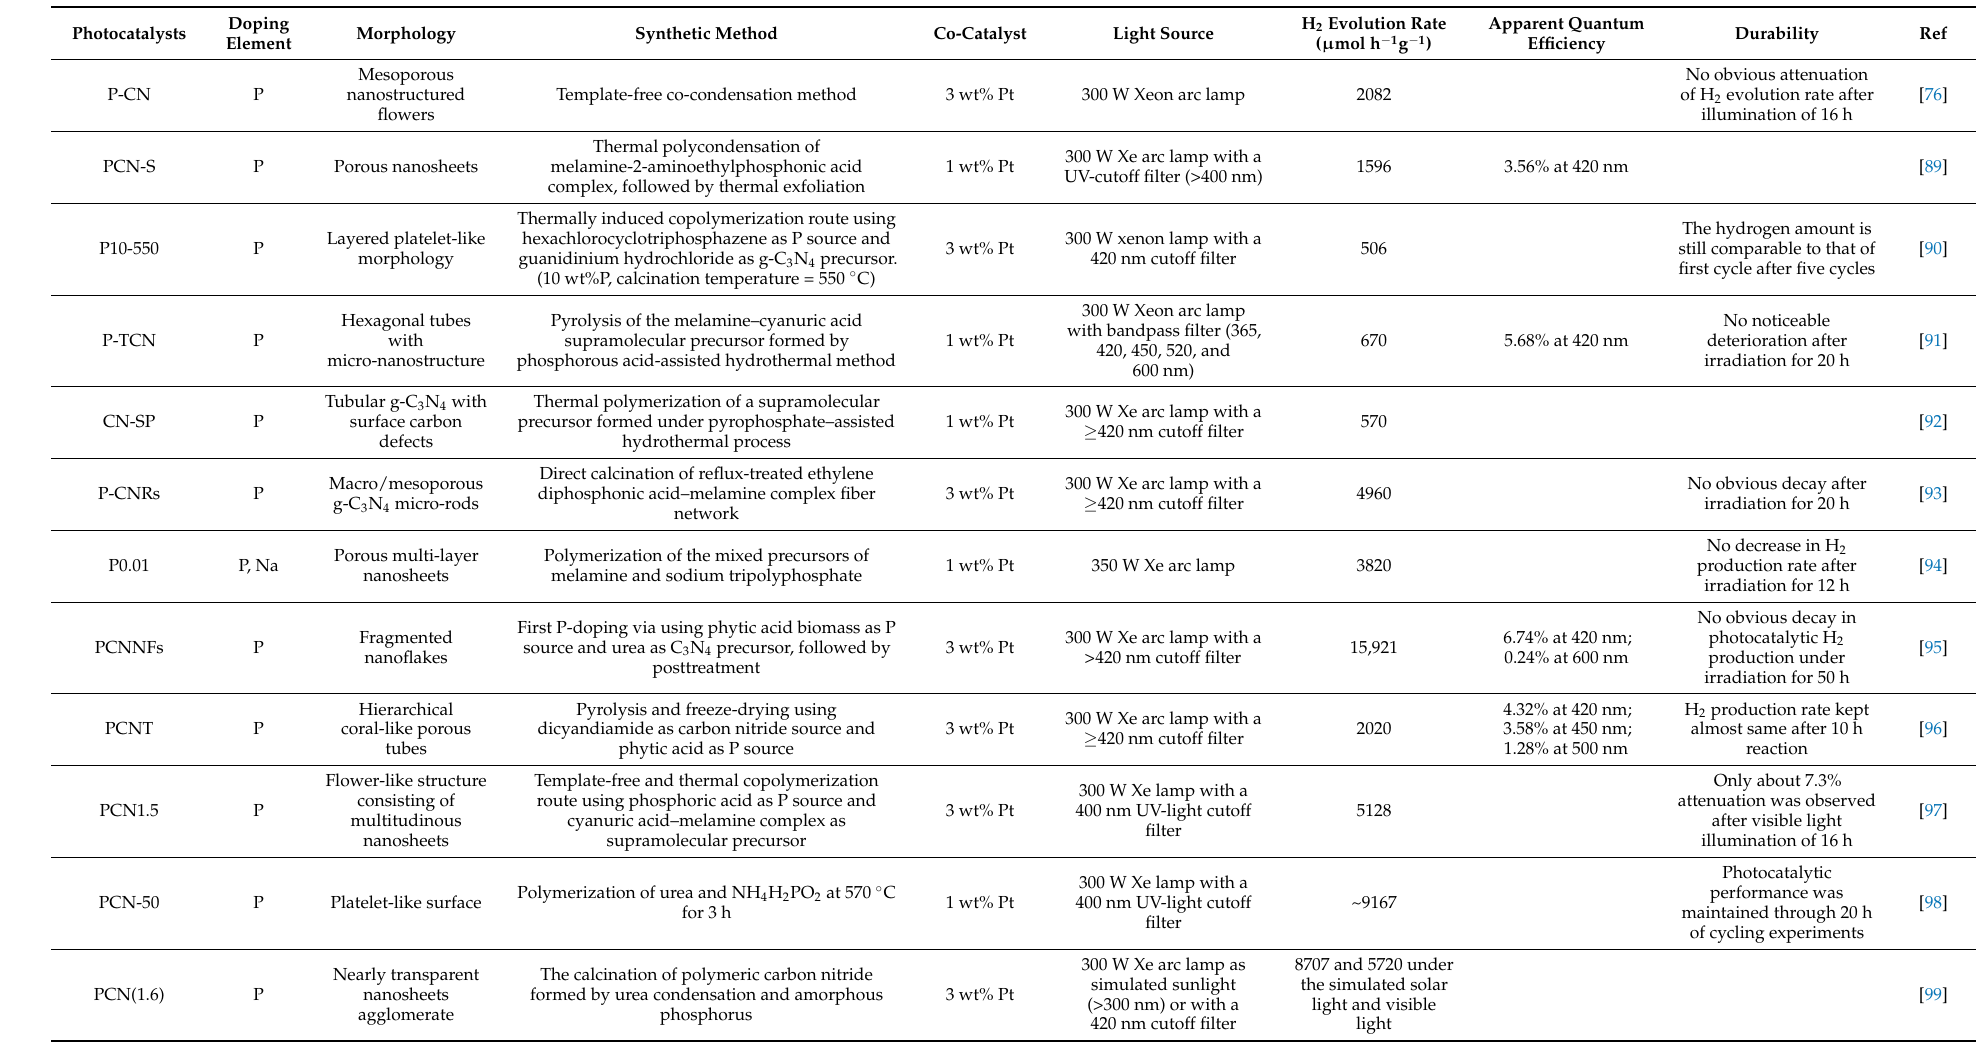
Table 6. Comparison of photocatalytic performance of mono heteroatom doped porous carbon nitride toward